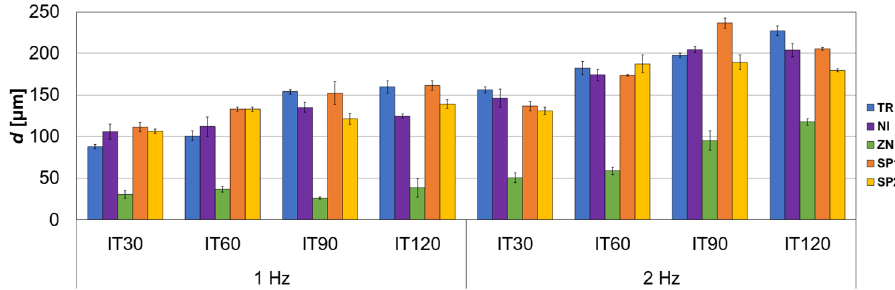
Figure 10. Influence of the duration of the tribological test on wear tracks depth. Error bars indicate the uncertainty of the measurements as standard deviation.